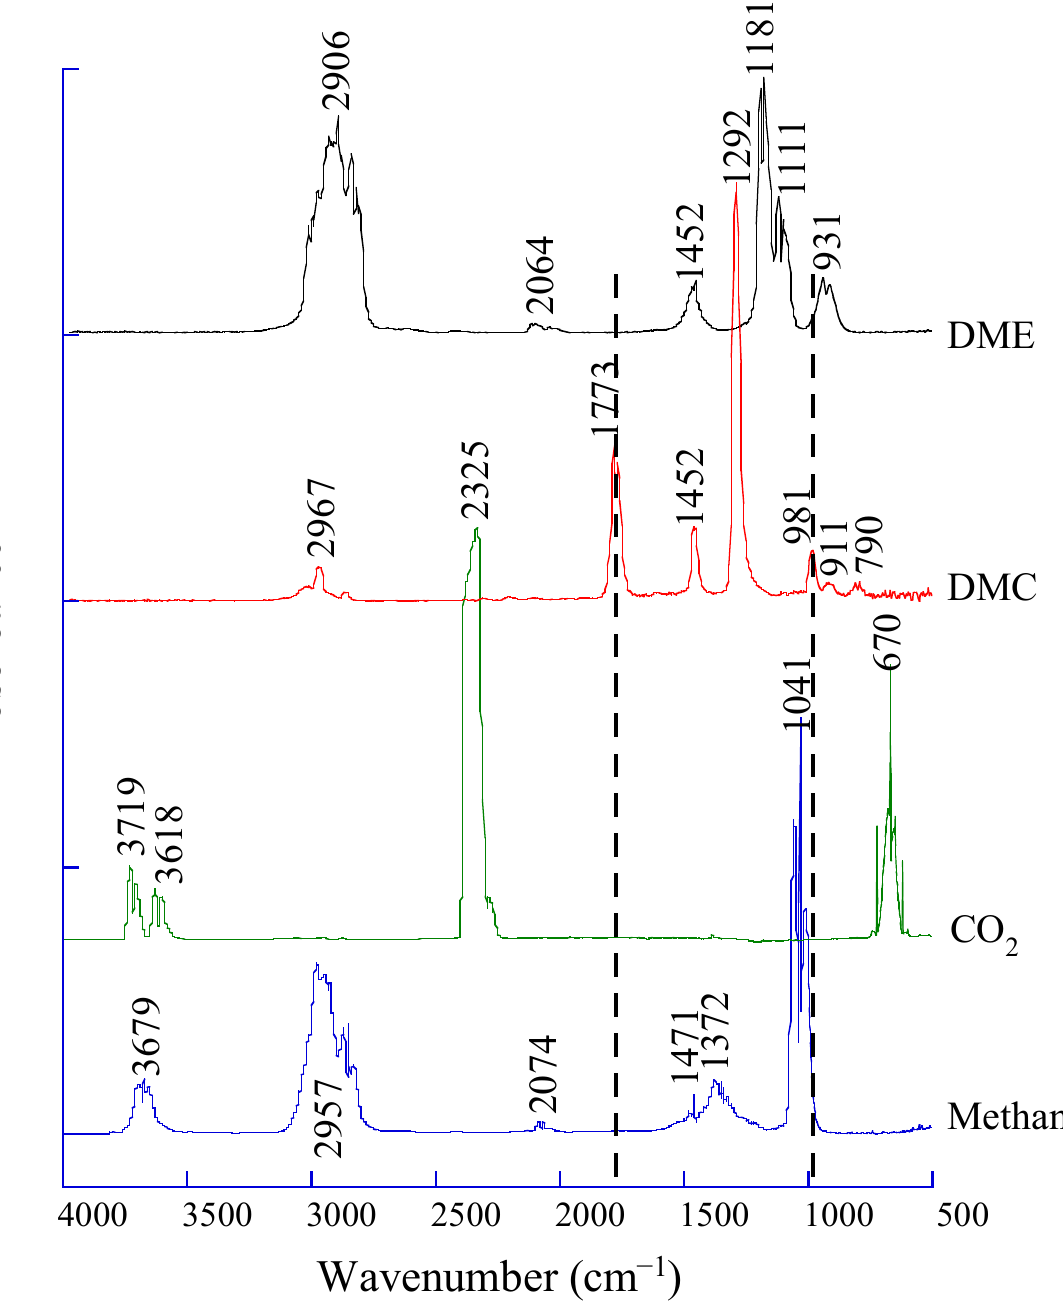
Figure 1- IR spectra of gaseous methanol, CO 2 , DMC and DME. Figure 1. IR spectra of gaseous methanol, CO 2 , DMC and